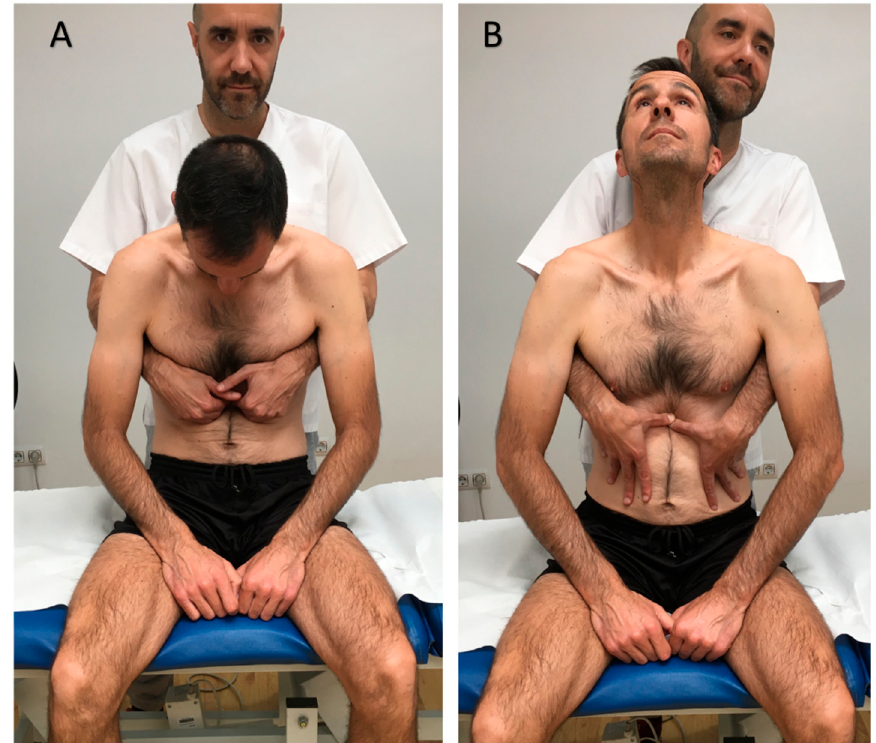
Figure 1. Osteopathic manual technique for the lower esophageal sphincter. ( A ). Initial position. ( B ). Final position.